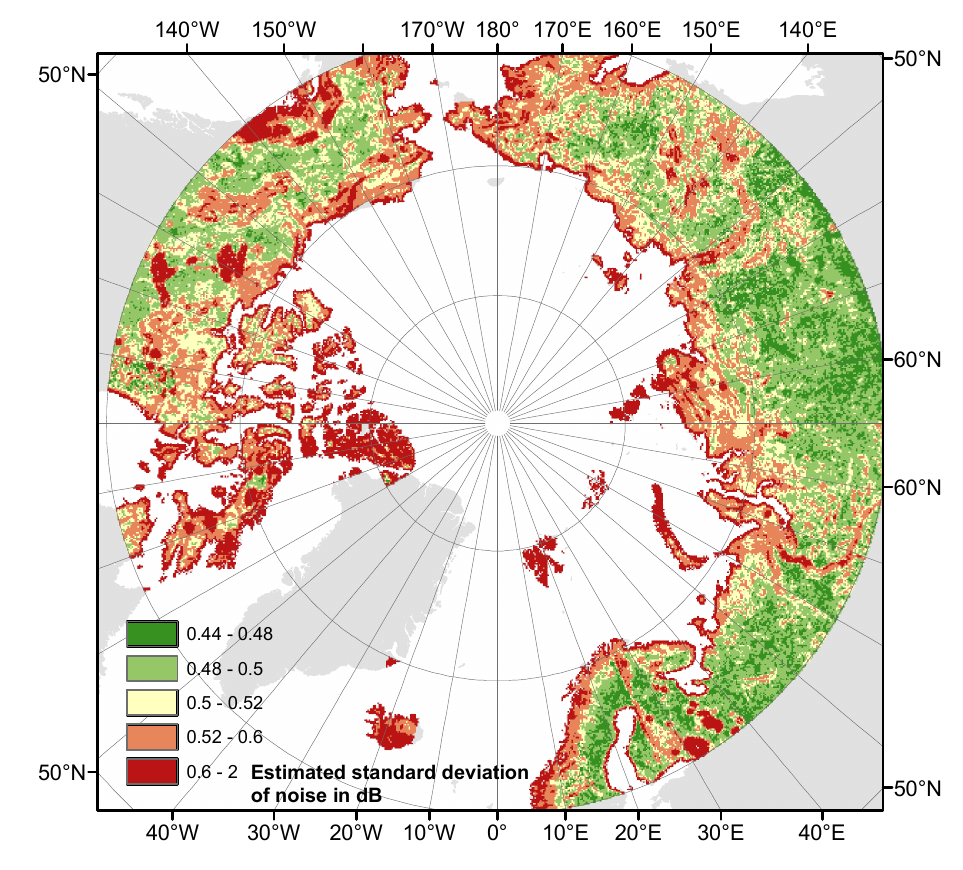
Figure 2. Estimated standard deviation of noise in dB ( s 60 ◦ N (excluding Greenland).